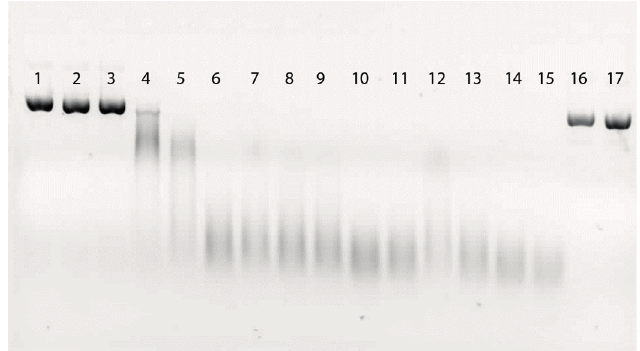
Figure 3. Effects of varying concentrations of EDTA on the enzymatic degradation of DNA. Each of the reactions loaded (1–15) contained 3 µL of fungal ( Verticillium dahlia ) DNase (2 Units), 2.2 µg plasmid DNA (in 10 mM MES pH 6.0) and 1 µL of the EDTA concentrations from 50 mM EDTA through half-fold dilutions to 0.003 mM EDTA. Reaction time was 10 min at 22 °C. Lanes 1, 2 and 3 with 50, 25 and 12 mM concentrations of EDTA, respectively, completely blocked DNA degradation. Treatments of 6.25 mM through 0.003 mM (Lanes 4–15) demonstrate the diminishing ability of EDTA to inhibit the DNase enzyme. Lanes 16 and 17 represent DNA controls without enzyme or